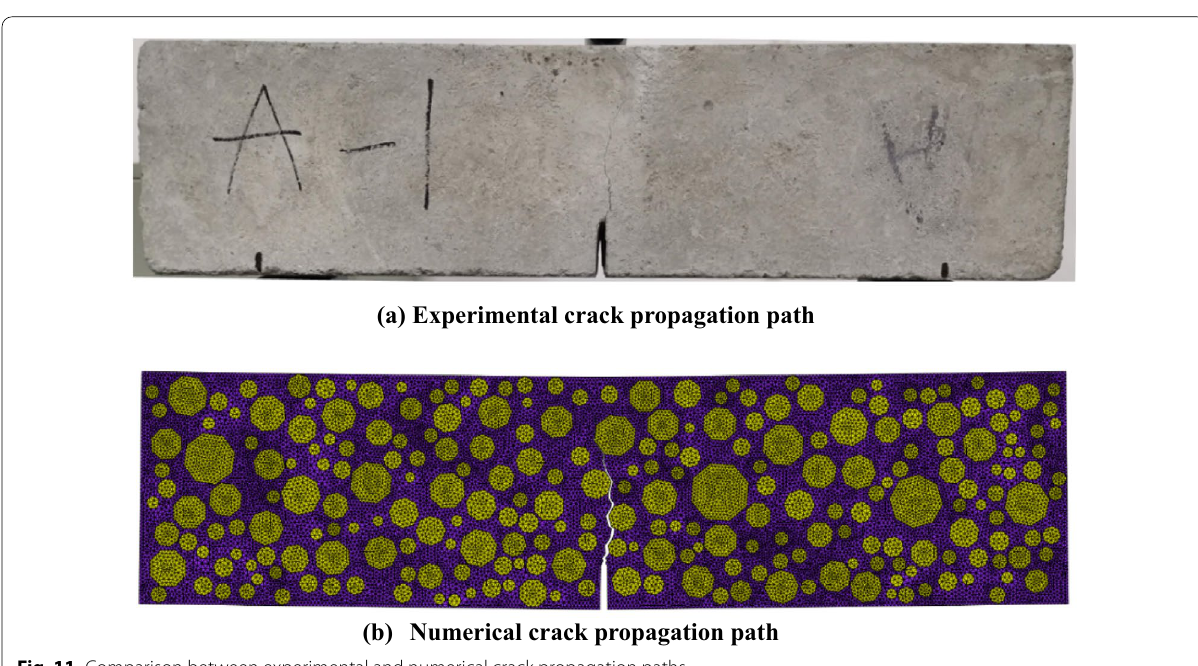
Fig. 11 Comparison between experimental and numerical crack propagation paths